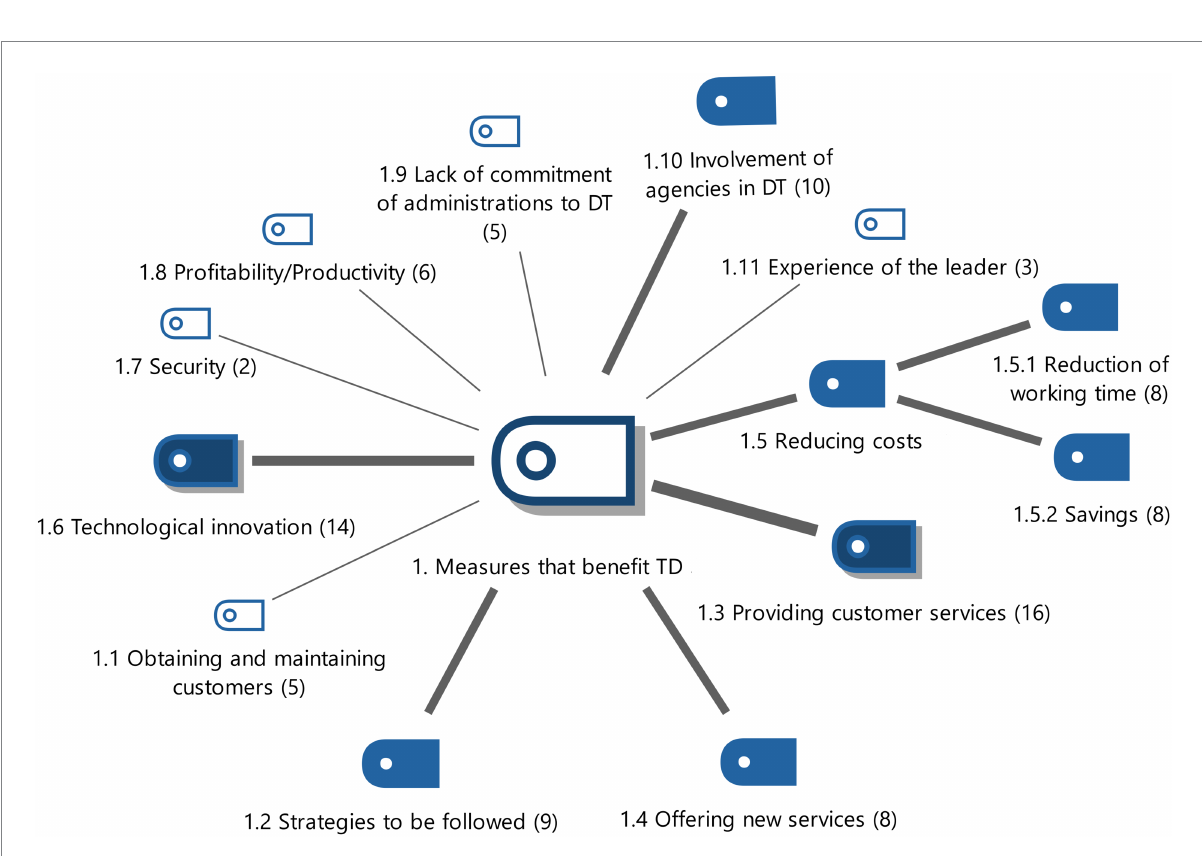
FIGURE 1 Measures that benefit DT with the weightings of the properties. Source: Authors